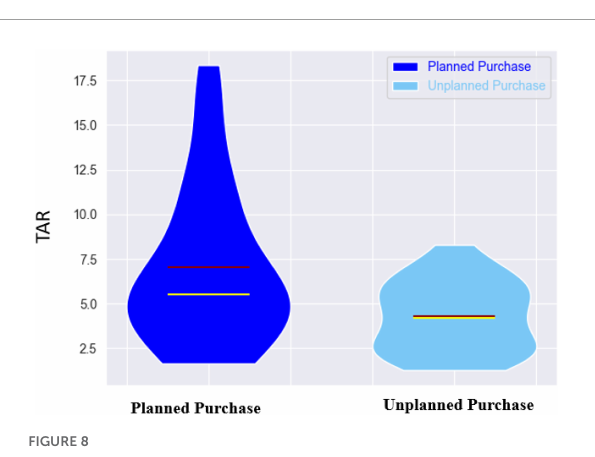
FIGURE8 The violin plots of TAR index across all subjects. The planned purchase and unplanned purchase conditions are shown with dark-blue and light-blue colors, respectively. The red and yellow lines in the middle illustrate the mean and median values,